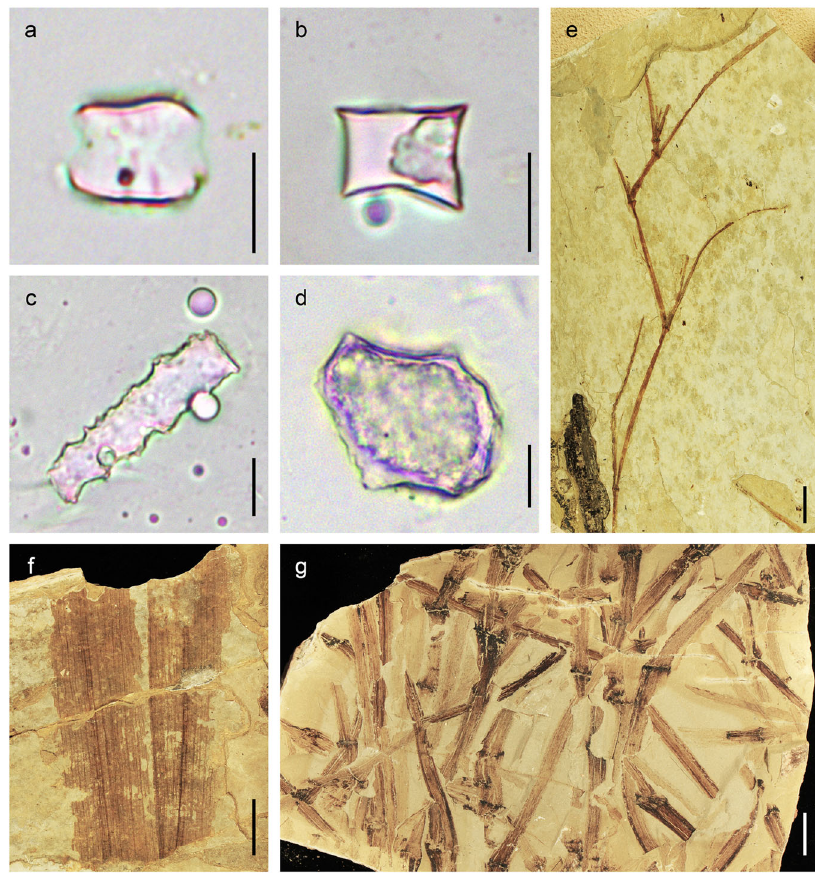
Fig. 4 Typical herbaceous fossils and phytoliths from the Dayu section. a – d Phytoliths in different forms extracted from the Dayu sediments. a True saddle; b Rondel; c Elongate; d Bulliform. e , f Herbaceous megafossils from Dayu section. e Sympodial branching; f Wide leaf with parallel veins; g Stem with swollen nodes. For phytolith analysis, we performed three replicate experiments with consistent results. (For a – d , scale bars = 10 µ m; for e , f , scale bars = 10